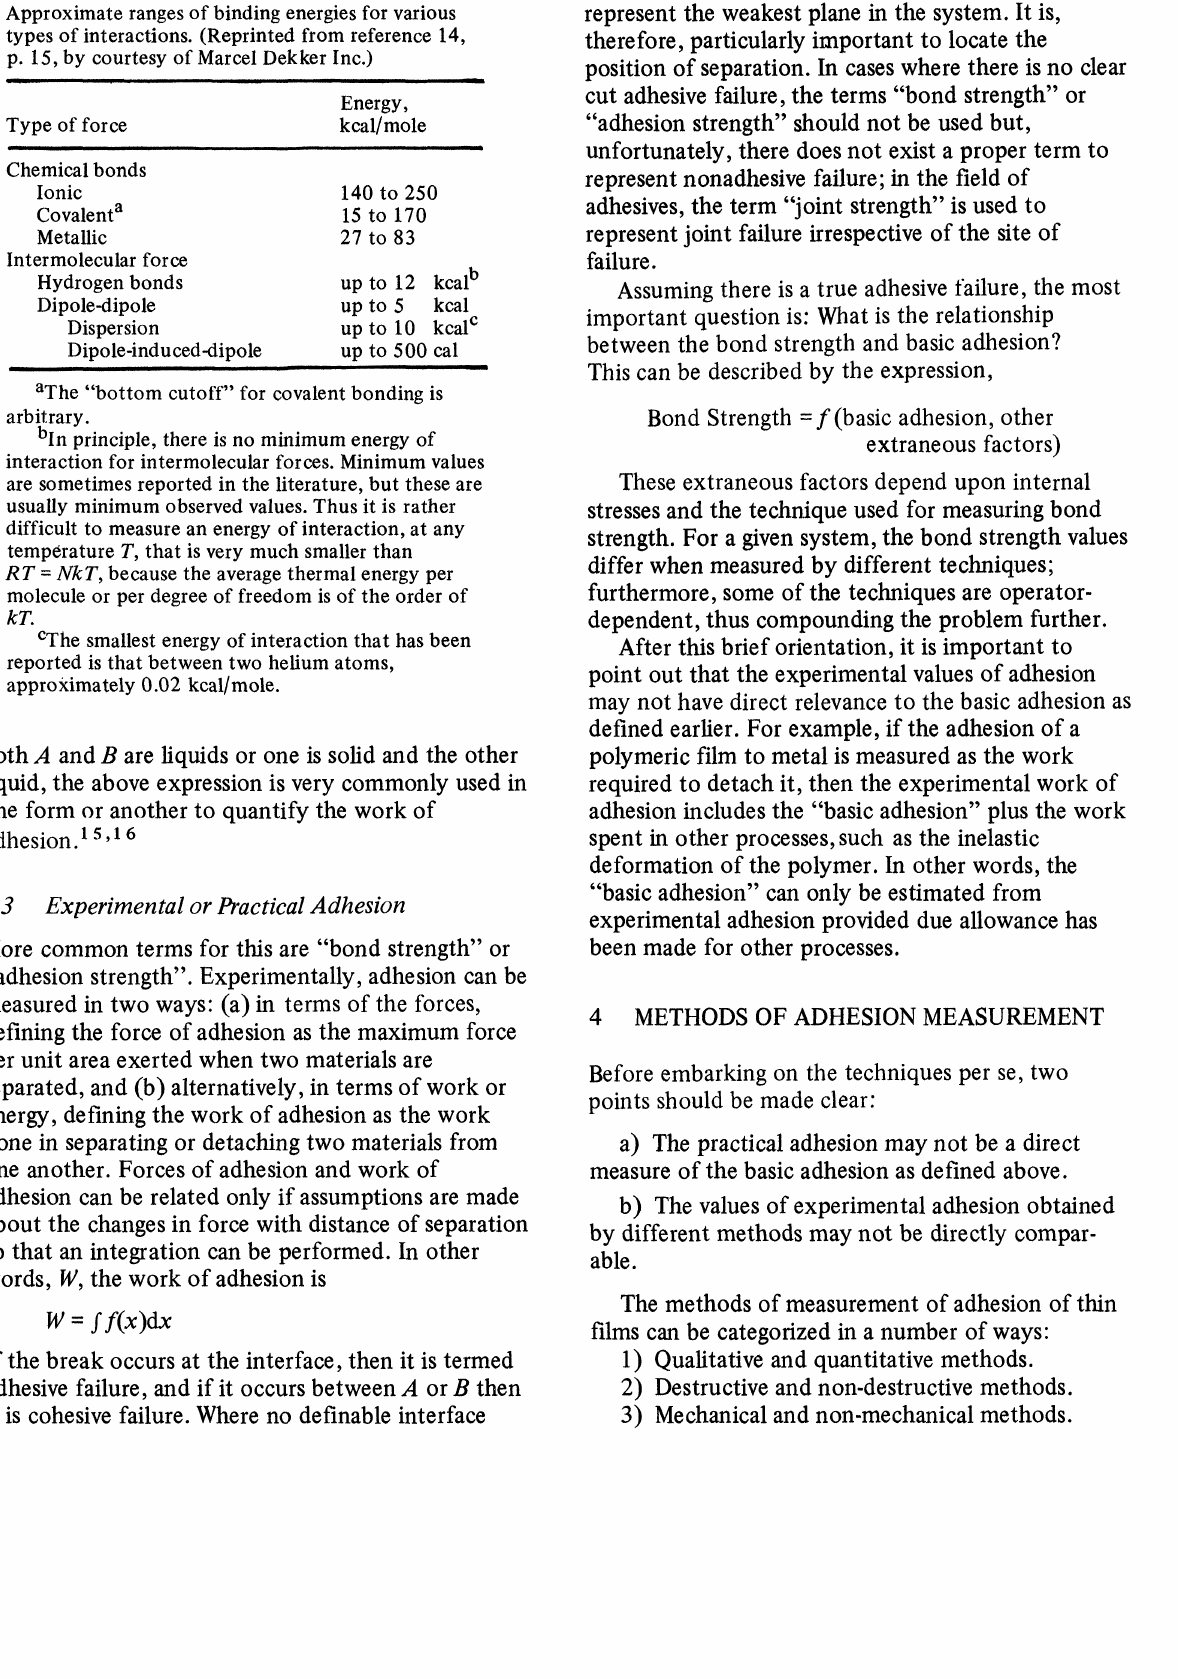
Approximate ranges of binding energies for various types of interactions. (Reprinted from reference 14, p. 15, by courtesy of Marcel Dekker